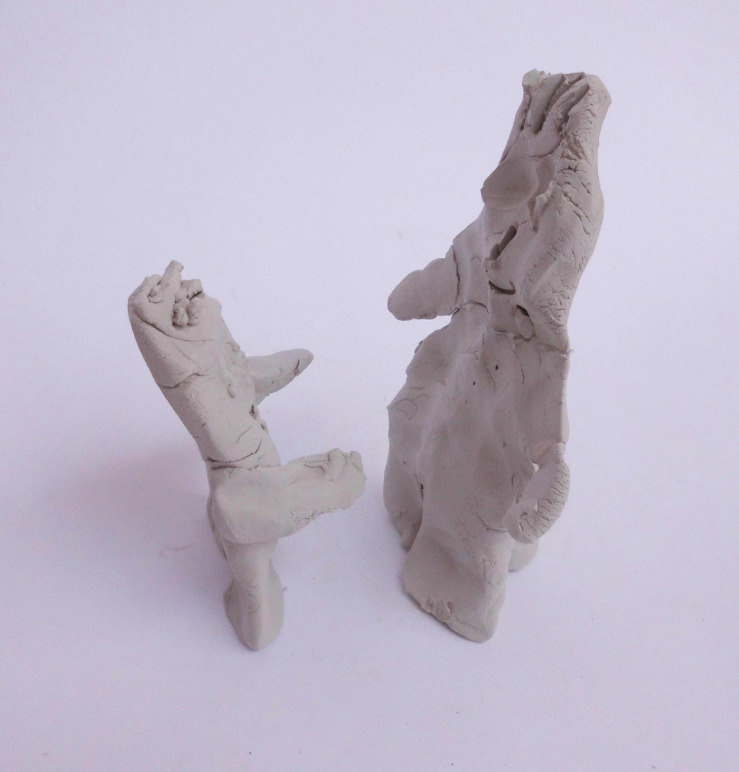
Tamir’s sculpture.